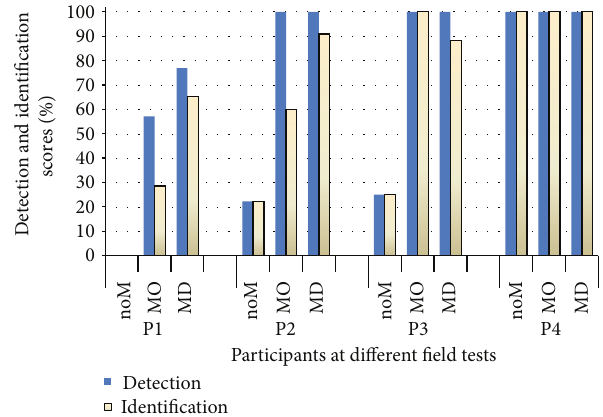
Figure 5: Detection and identification scores of events occurring in a traffic environment for four participants with Usher’s Syndrome type I, when they were tested without Monitor (noM), with Monitor with omnidirectional microphone (MO), and with Monitor with directional microphone (MD). In the noM situation the Ps only detected the events coming from behind when the object had passed